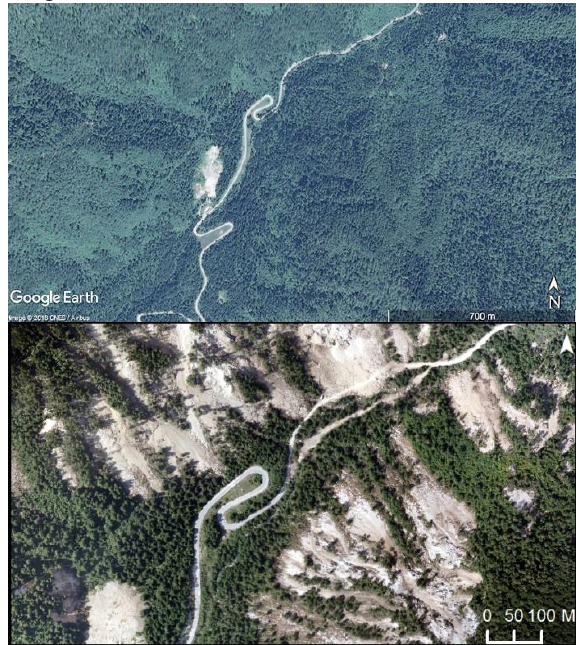
Figure 2. Comparison images of the study area pre- and post- earthquake (The top map was Google Earth image before earthquake. The bottom map was UAV image)